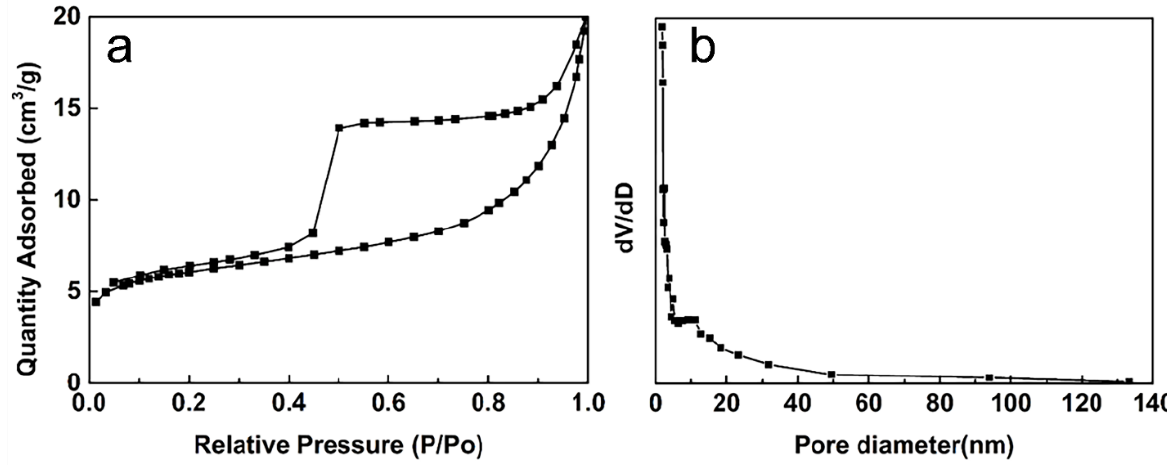
Figure 9. The A27H6 ( a ) adsorption/desorption isotherms and ( b ) pore size distribution.